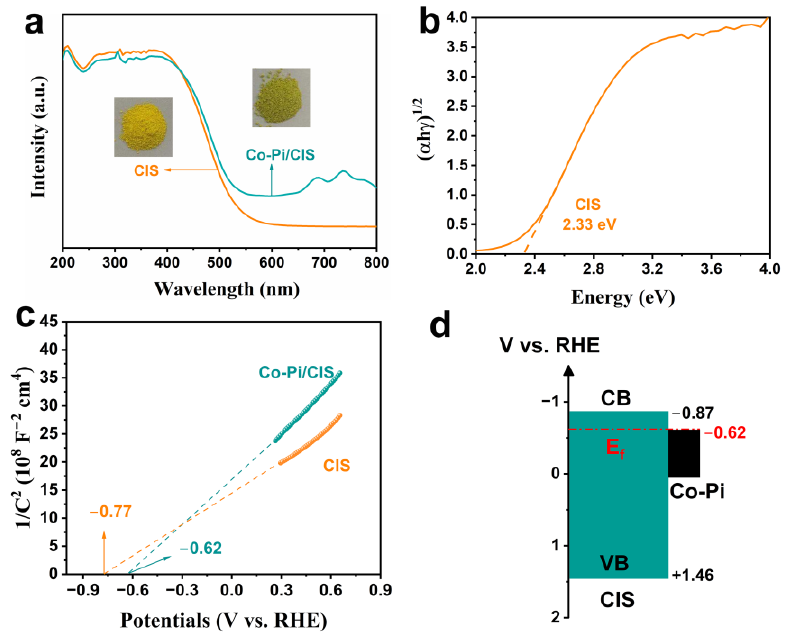
Figure 4. ( a ) Ultraviolet-visible diffuse reflection spectra (UV-Vis DRS) and photograph, ( b ) Tauc plot, and ( c ) Mott-Schottky (M-S) plot of the samples. ( d ) Band alignment of Co-Pi/CIS